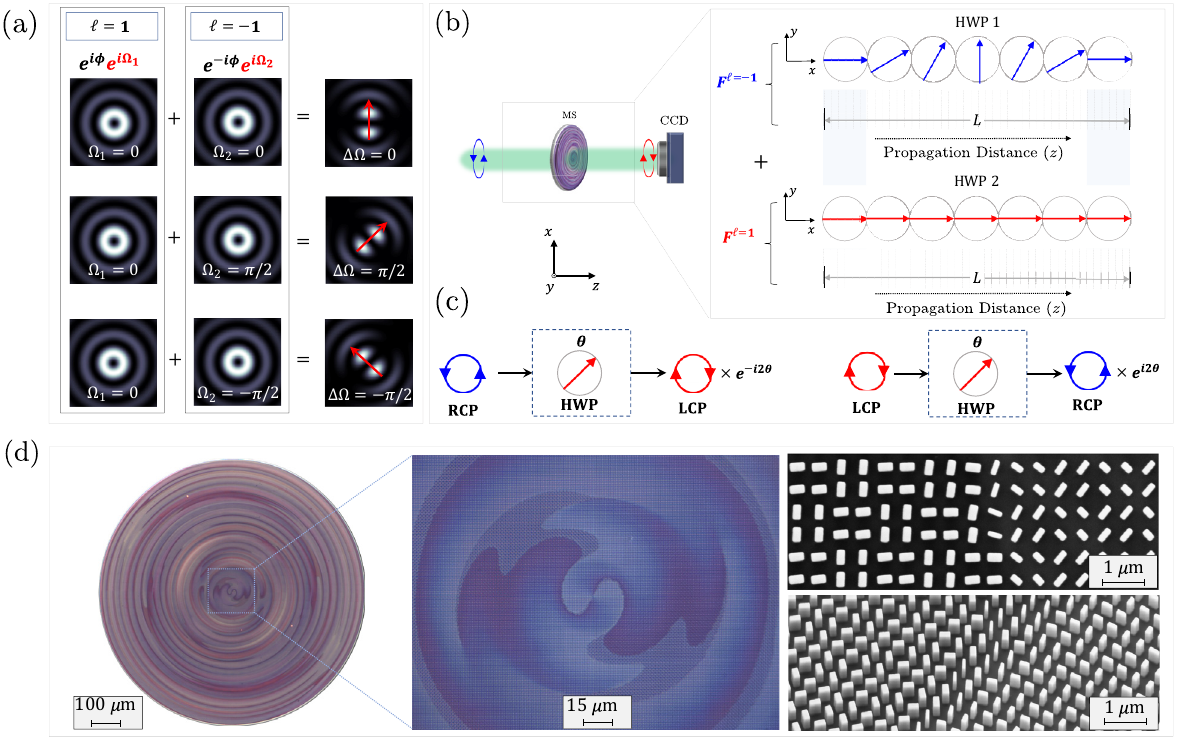
Figure 4: Optical vortex beams with spatially evolving Berry phase: design principle and implementation. (a) Superposition of two vortex modes with opposite helicity, 𝓁 = 1 and 𝓁 = − 1, produces a petal structure which rotates depending on the − Ω . (b) Schematic of our metasurface profile for detecting the Berry phase: relative phase shift ( ΔΩ ) between the vortex modes; ΔΩ = Ω 2 1 two vortex modes with opposite helicity, 𝜓 𝓁 =− 1 and 𝜓 𝓁 = 1 , experience different HWP-like polarization transformations. The fast axis of HWP-1 rotates with propagation (blue arrows) whereas HWP-2 orientation is fixed (red arrows). Hence, only 𝜓 𝓁 =− 1 experiences a propagation-dependent polarization transformation. (c) A typical HWP would reverse the handedness of input RCP and LCP light at the output while imparting a Berry phase which depends on the orientation of its fast axis ( 𝜃 ). (d) Optical microscope and SEM images of the fabricated metasurface for the direct measurement of propagation-dependent Berry phase. The sample shows characteristic twisted patterns hinting at their function; converting a plane wave into two co-propagating vortex beams which result in rotating petal-like structure.